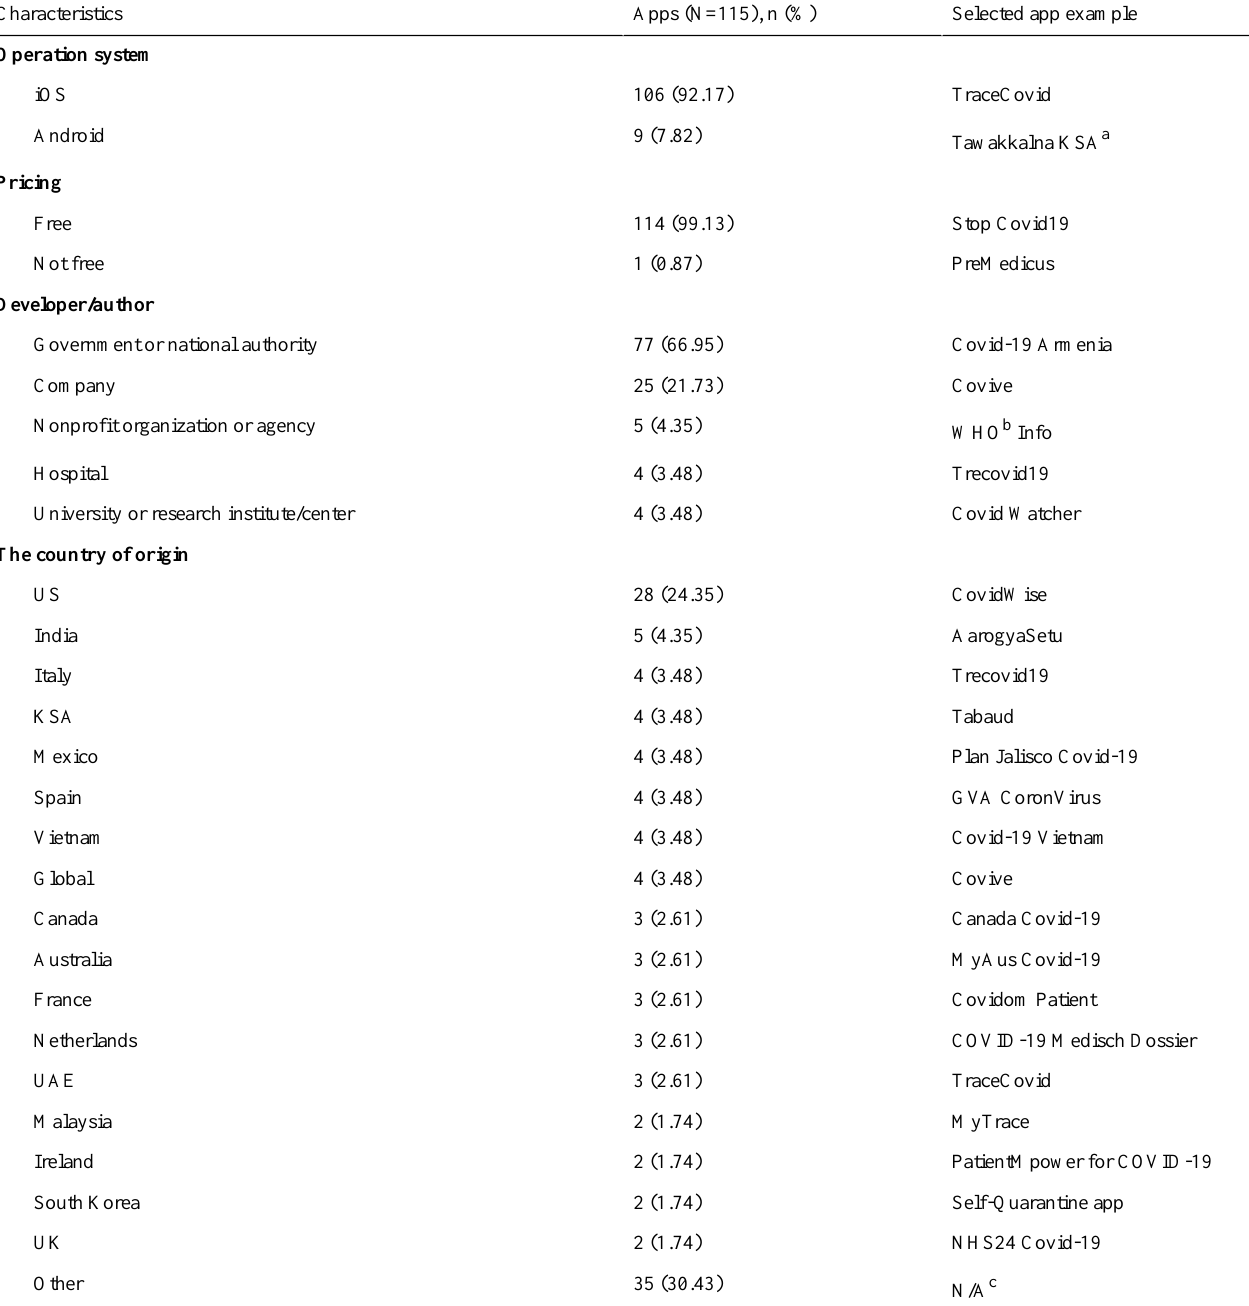
Table 2. Summary of